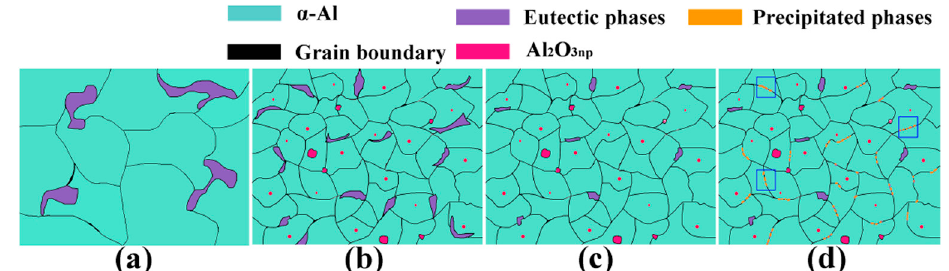
Figure 4. The distribution schematic of Al 2 O 3np reinforced particles in 7075 aluminum under different processing states: ( a ) 7075 aluminum matrix as-cast; ( b ) Al 2 O 3np /7075 composites; ( c ) Al 2 O 3np /7075 composites under heat treatment at 480 °C for 5 h; ( d ) Al 2 O 3np /7075 composites under heat treatment at 480 °C for 5 h and 120 °C for 24 h.